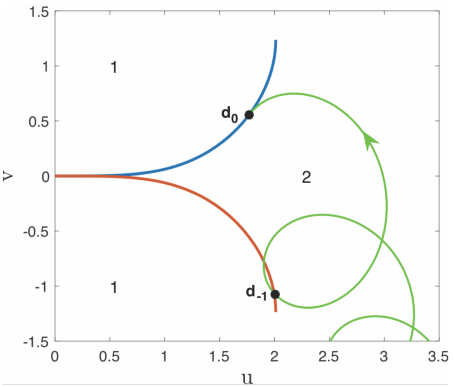
on the portion of the red − 1 −